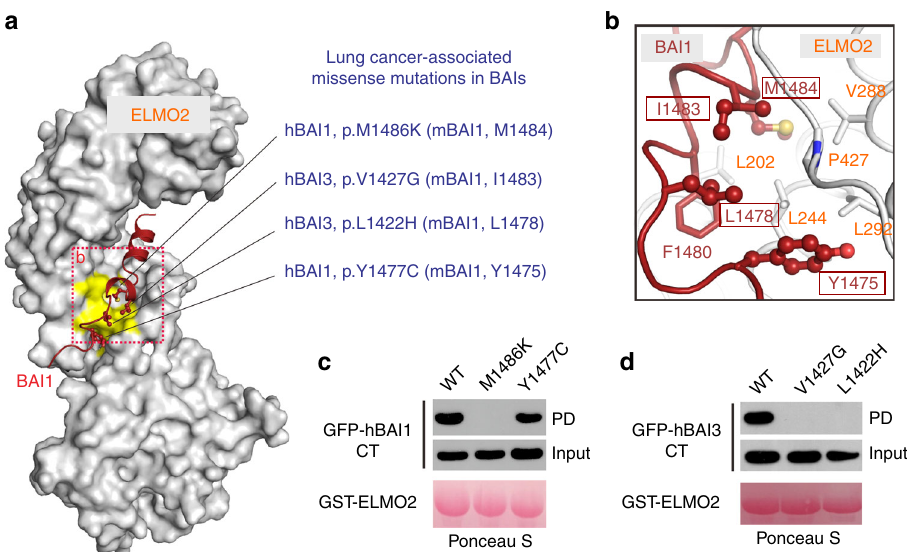
Fig. 5 Cancer-associated mutations in BAI/ELMO interface. a Four lung cancer-associated missense mutations in BAIs mapped on to the interface of the complex structure. In this drawing, the side chains of key residues associated with cancers are shown in the stick mode, and the residues on ELMO2 that coordinate these cancer-related residues are color in yellow. b Zoomed-in view of binding details of cancer-related residues shown in panel a . c , d Effects of the cancer-associated mutations on the formations of the BAI1-CT/ELMO2-RAE ( c ) and BAI3-CT/ELMO2-RAE ( d ) complexes based on the GST-pull down